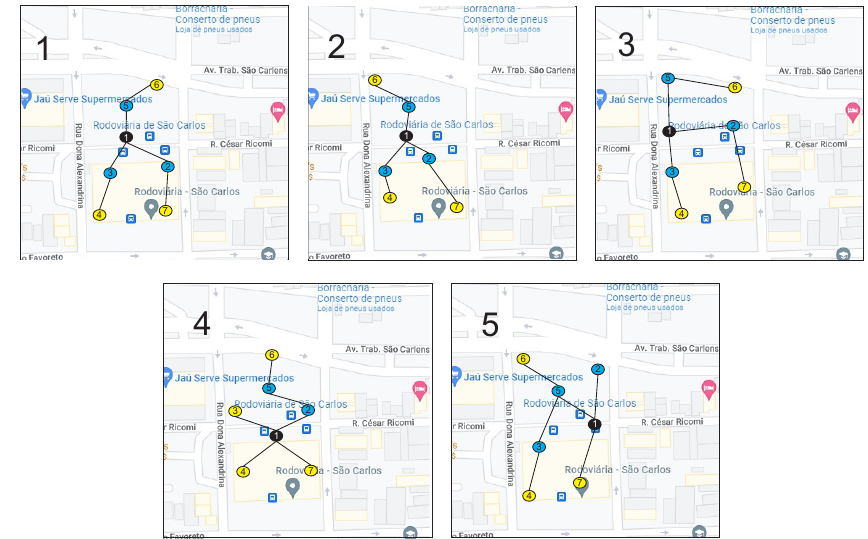
Figure 5. Experiment Scenarios on Google Maps.